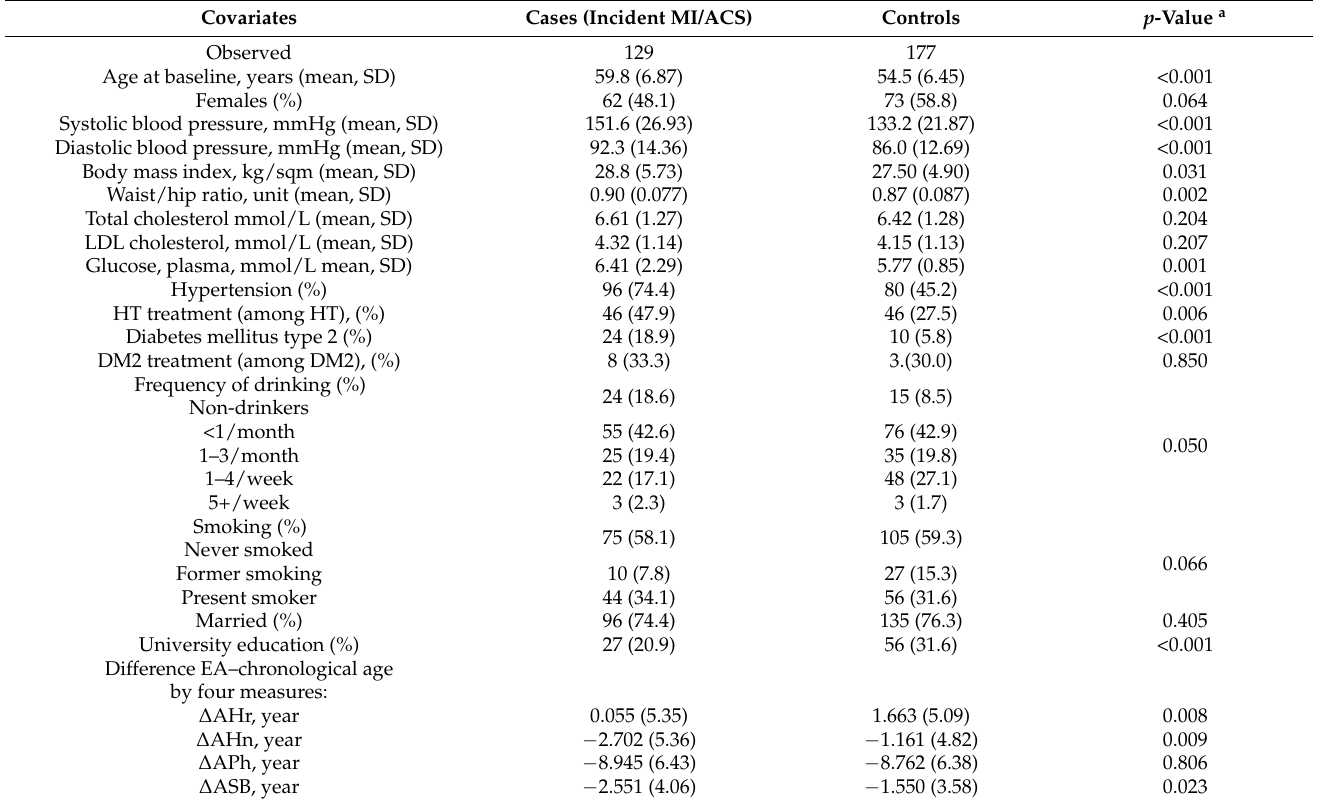
Table 1. Distribution of baseline covariates among cases of incident MI/ACS and control (the Russian arm of the HAPIEE